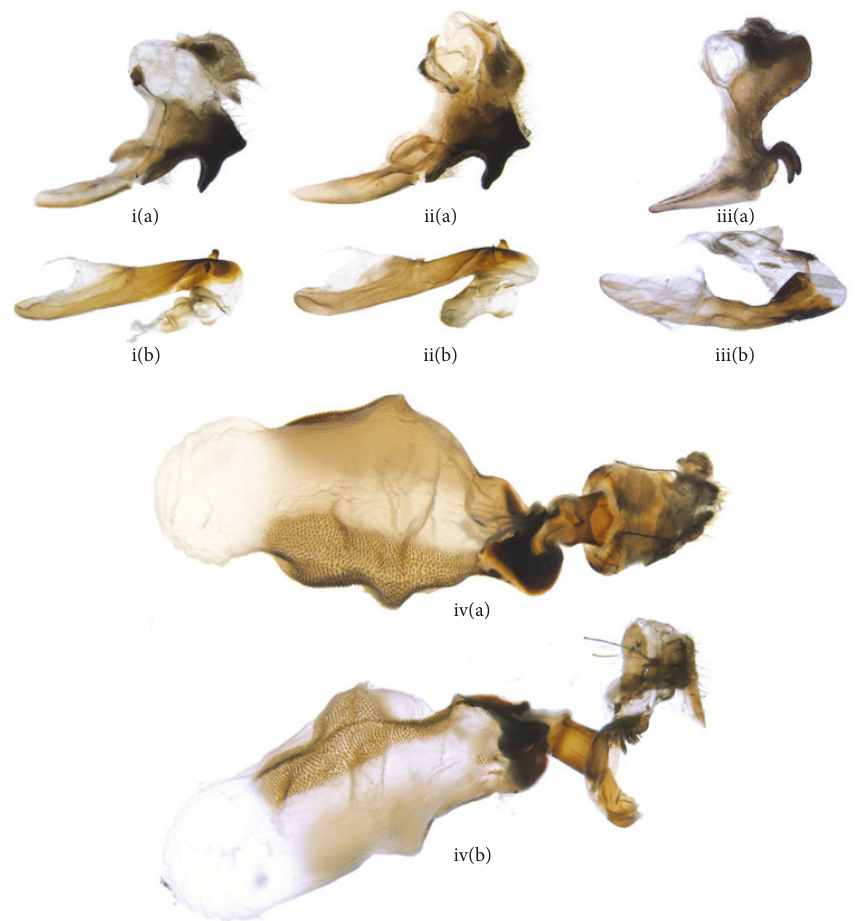
Figure 3: Genitalia morphology. Male genitalia of D. chrysippus : i(a) lateral view of genital capsule, i(b) aedeagus; male genitalia of offspring from second instance: ii(a) lateral view of genital capsule, ii(b) aedeagus; male genitalia of D. genutia : iii(a) lateral view of genital capsule, iii(b) aedeagus; genitalia of female offspring which is similar to D. chrysippus : iv(a) dorsal view and iv(b) lateral